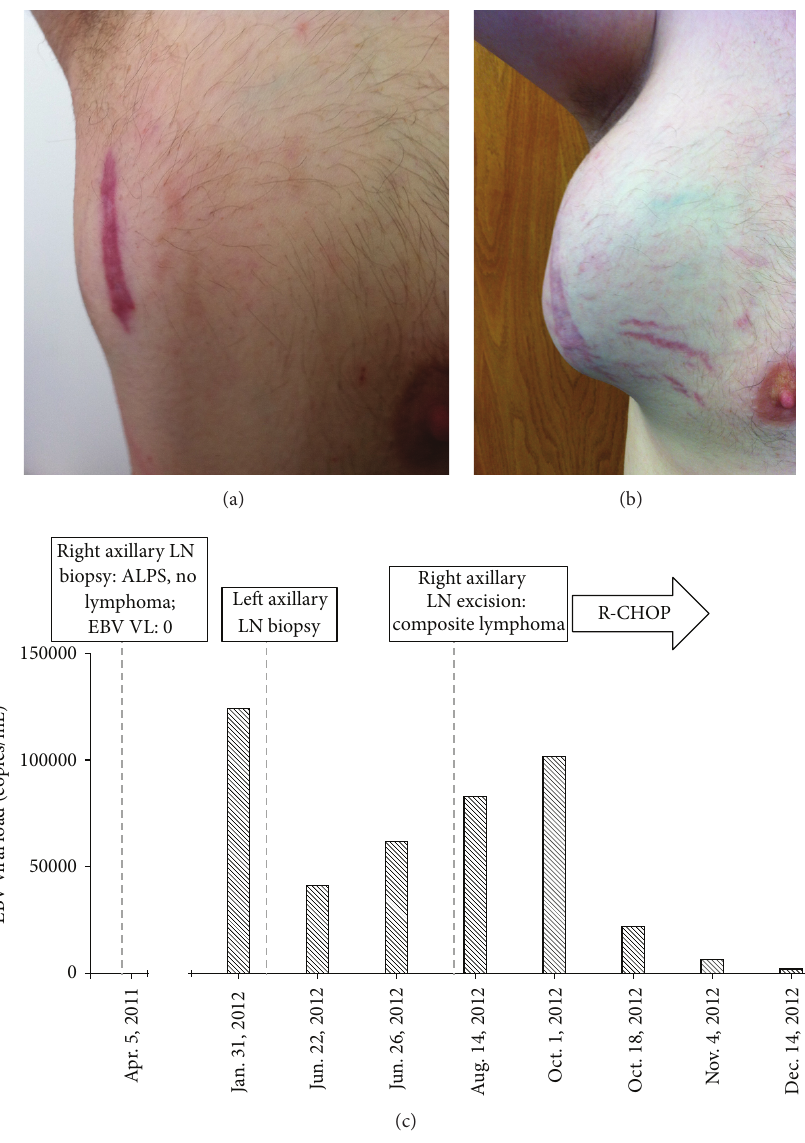
Figure 1: EBV viremia and EBV + lymphoma in ALPS. A 33-year-old male with ALPS-Ia developed asymptomatic worsening lymphadenopa- thy (Right axillary lymph node in July 2011 (a) and June 2012 (b)), with progressively increasing EBV viral load (VL). He was found to have a composite EBV + lymphoma. (c) Monitoring of whole blood EBV VL demonstrates an increasing viremia with concomitant identification of lymphoma and improvement in viremia with (rituximab, cyclophosphamide, doxorubicin, vincristine, and prednisone; R- CHOP)